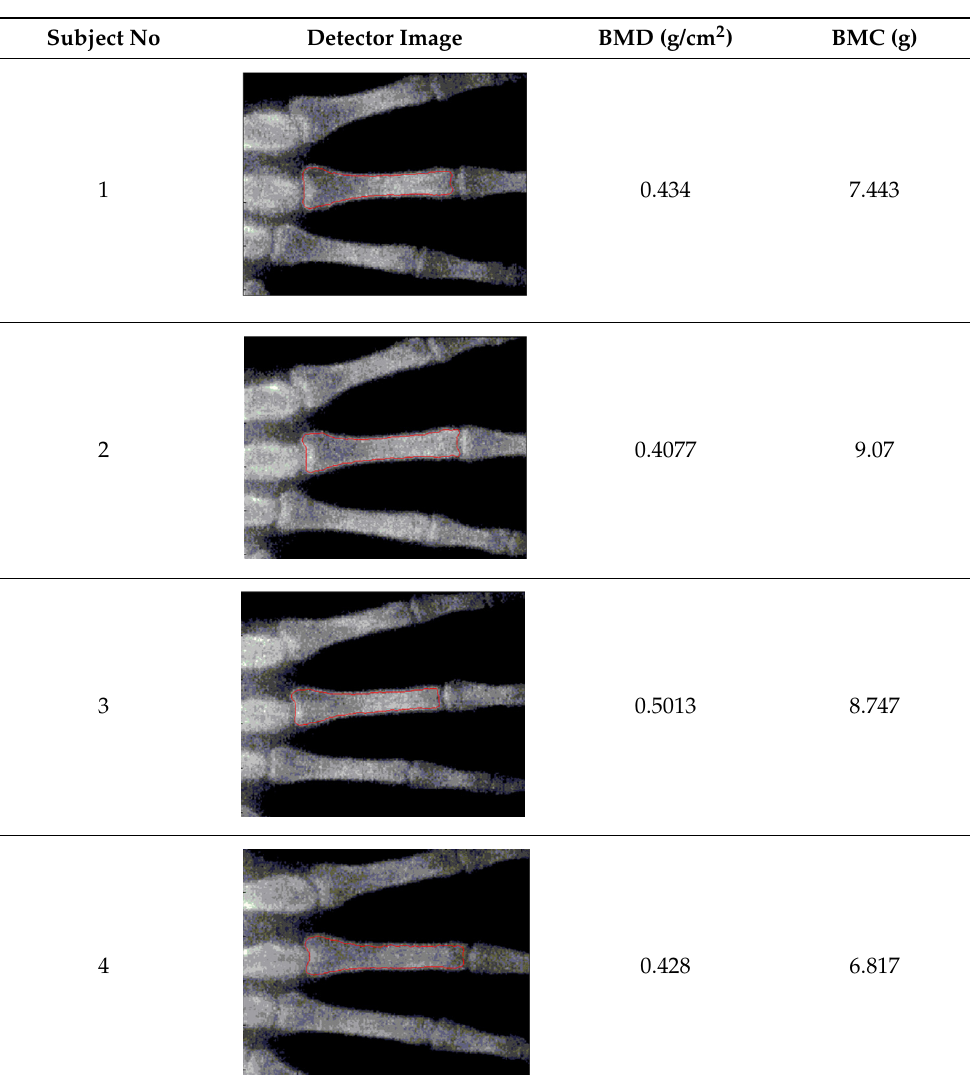
Figure 12. Plot of real calicium content (x axis) against computed mineral (calcium) content (y axis).